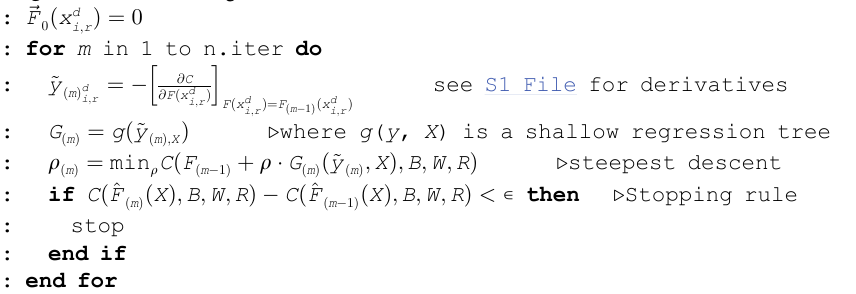
Algorithm 1 scores the performance in each challenge a subject encountered during a